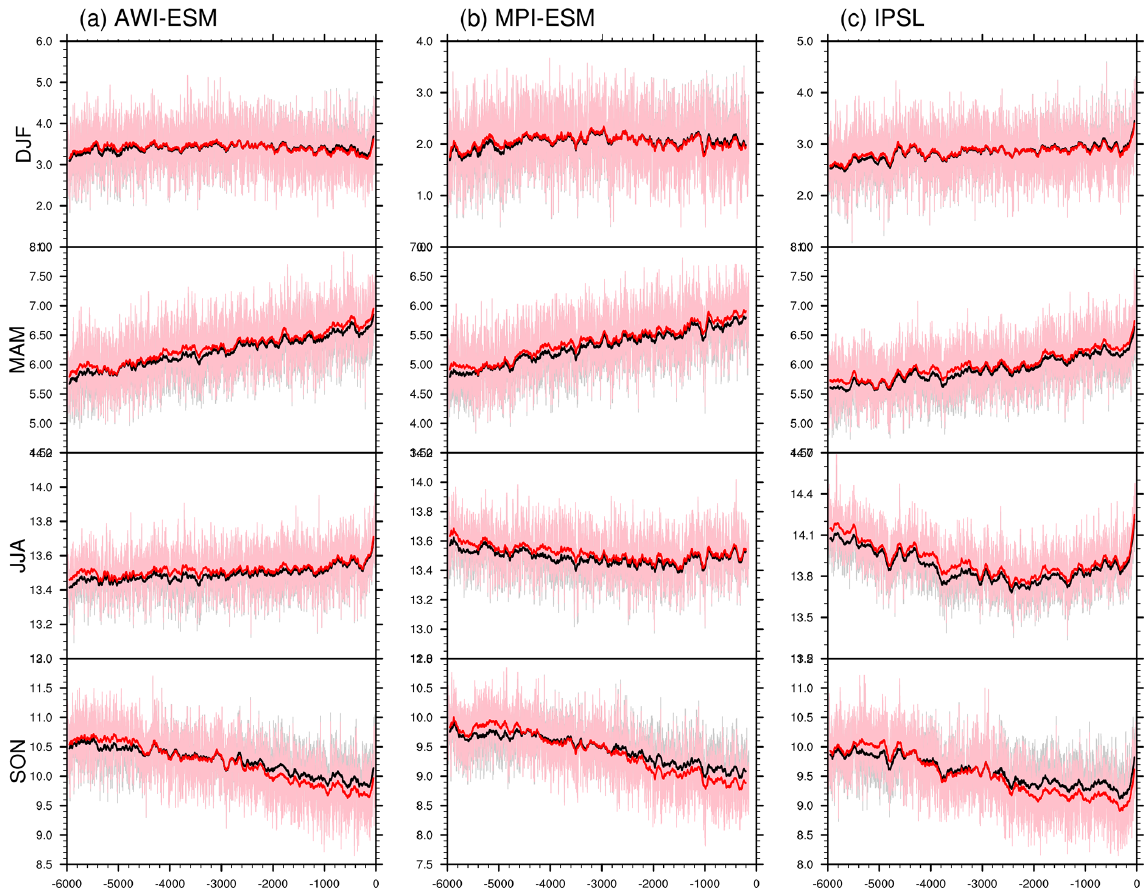
Figure 13. Time series of surface air temperature in classical and angular means averaged over Northern Hemisphere oceans, weighted by month length, for (a) AWI-ESM, (b) MPI-ESM, and (c) IPSL-CM. Grey and pink lines stand for the original classical and angular means respectively. Smoothed curves with a running window of 100 model years are shown in black (for classical means) and red (for angular means). Units: ◦